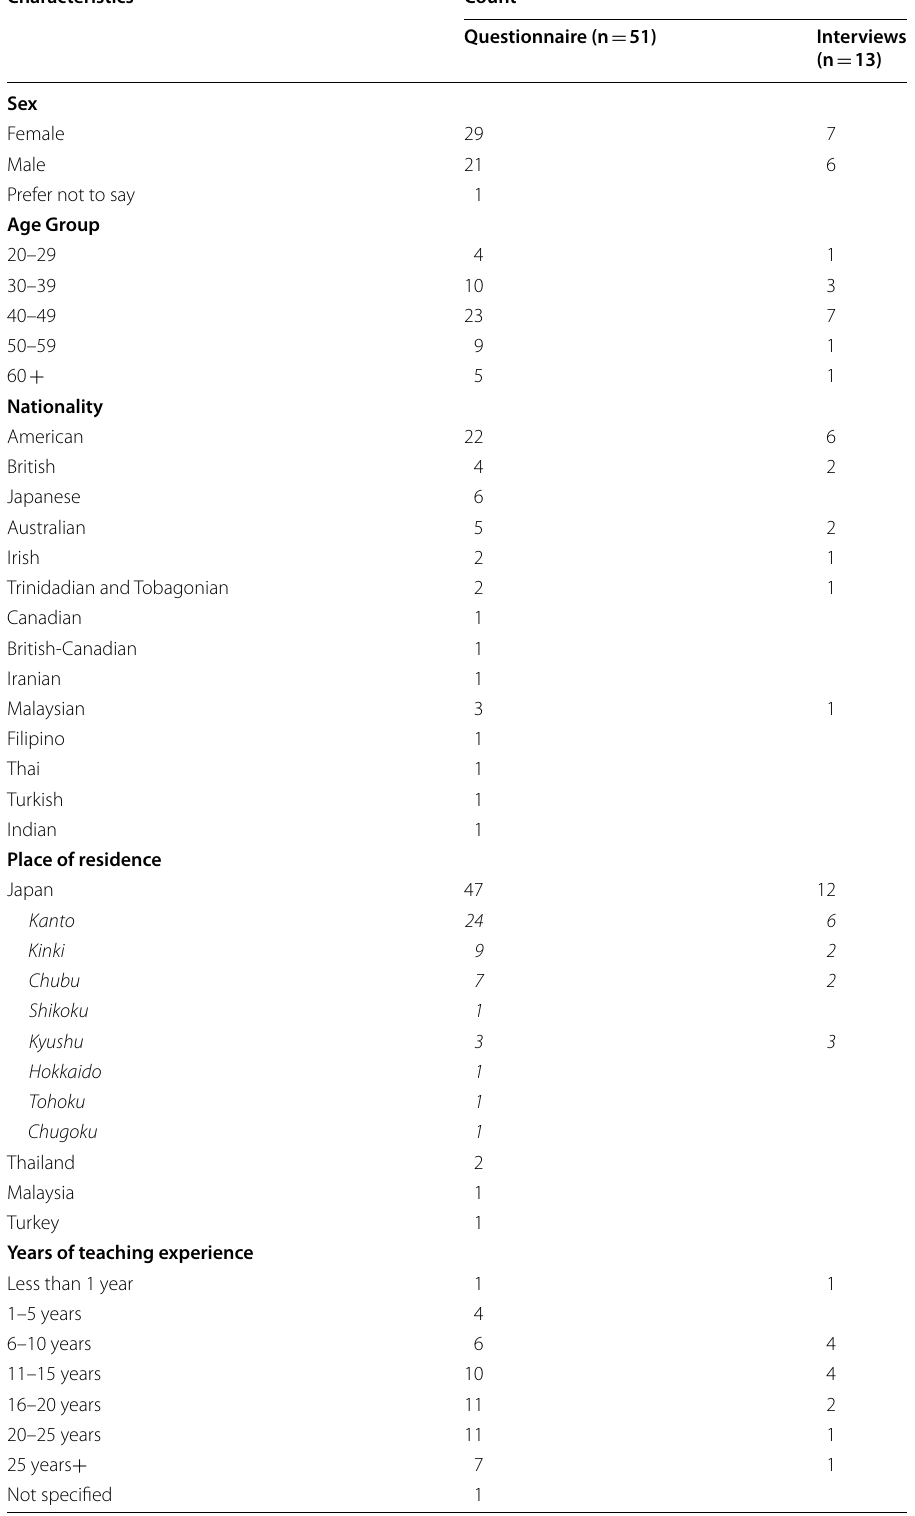
Table 4 Characteristics and details of the questionnaire respondents and interviewees